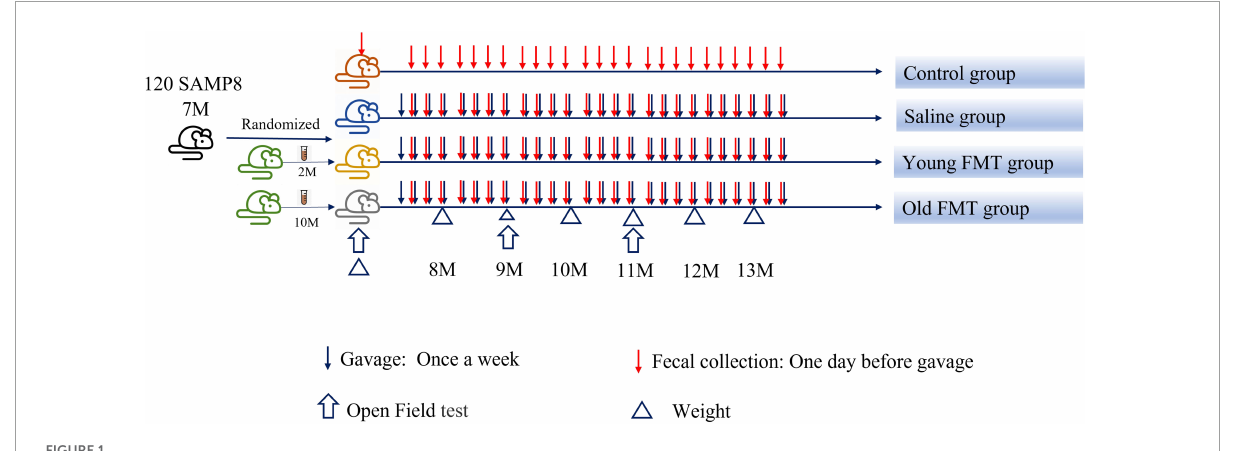
FIGURE1 Scheme of the study procedure. FMT, fecal microbiota